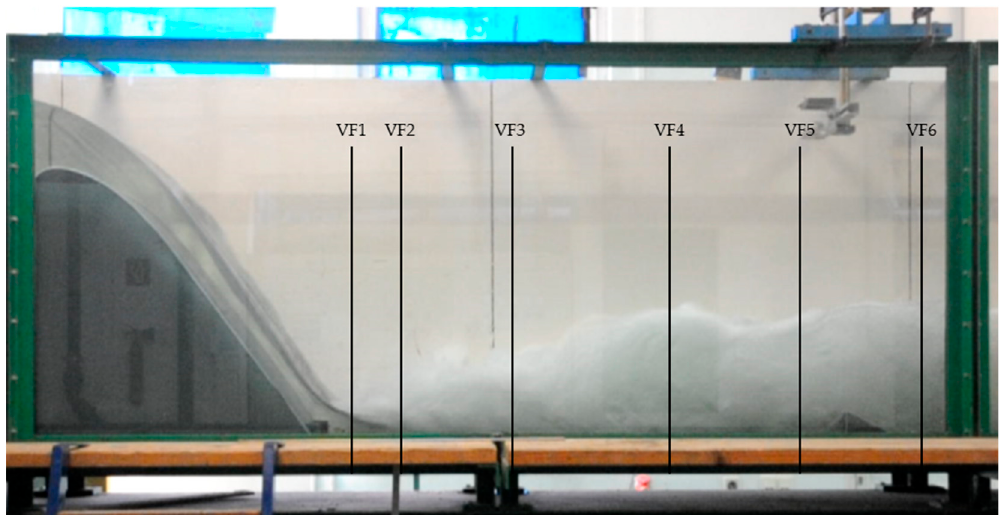
Figure 3. Physical model of the case study at the TUWien Hydraulics Laboratory with the profiles used to measure the void fraction in the experimental campaign (VF1–VF6).